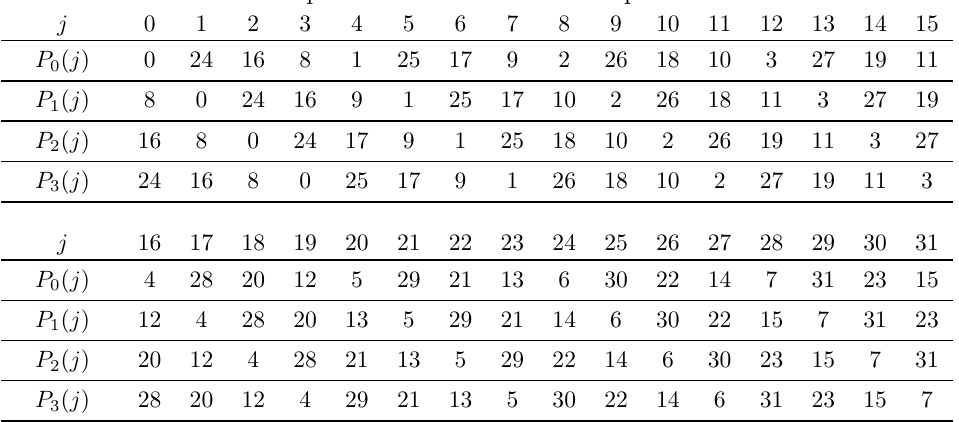
Table 2: Specifications of GIFT-128 bit